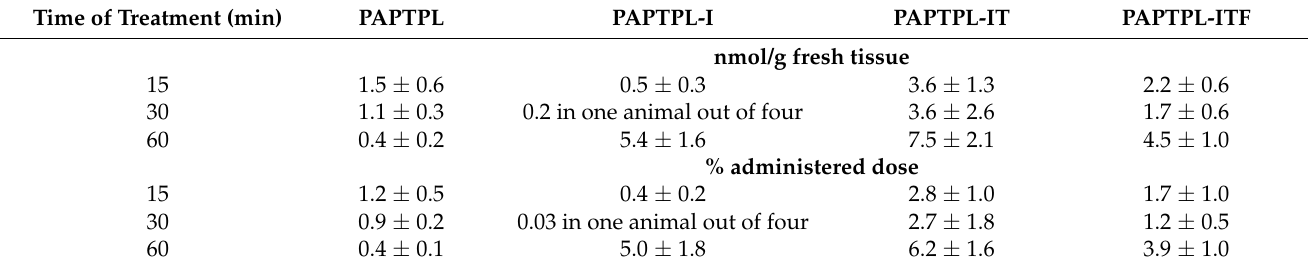
Table 2. Quantification of An2-PAPTP-derived metabolites in the liver. Data are expressed as mean ± SEM ( n = 5, 4, and 6 for 15, 30 and 60 min,